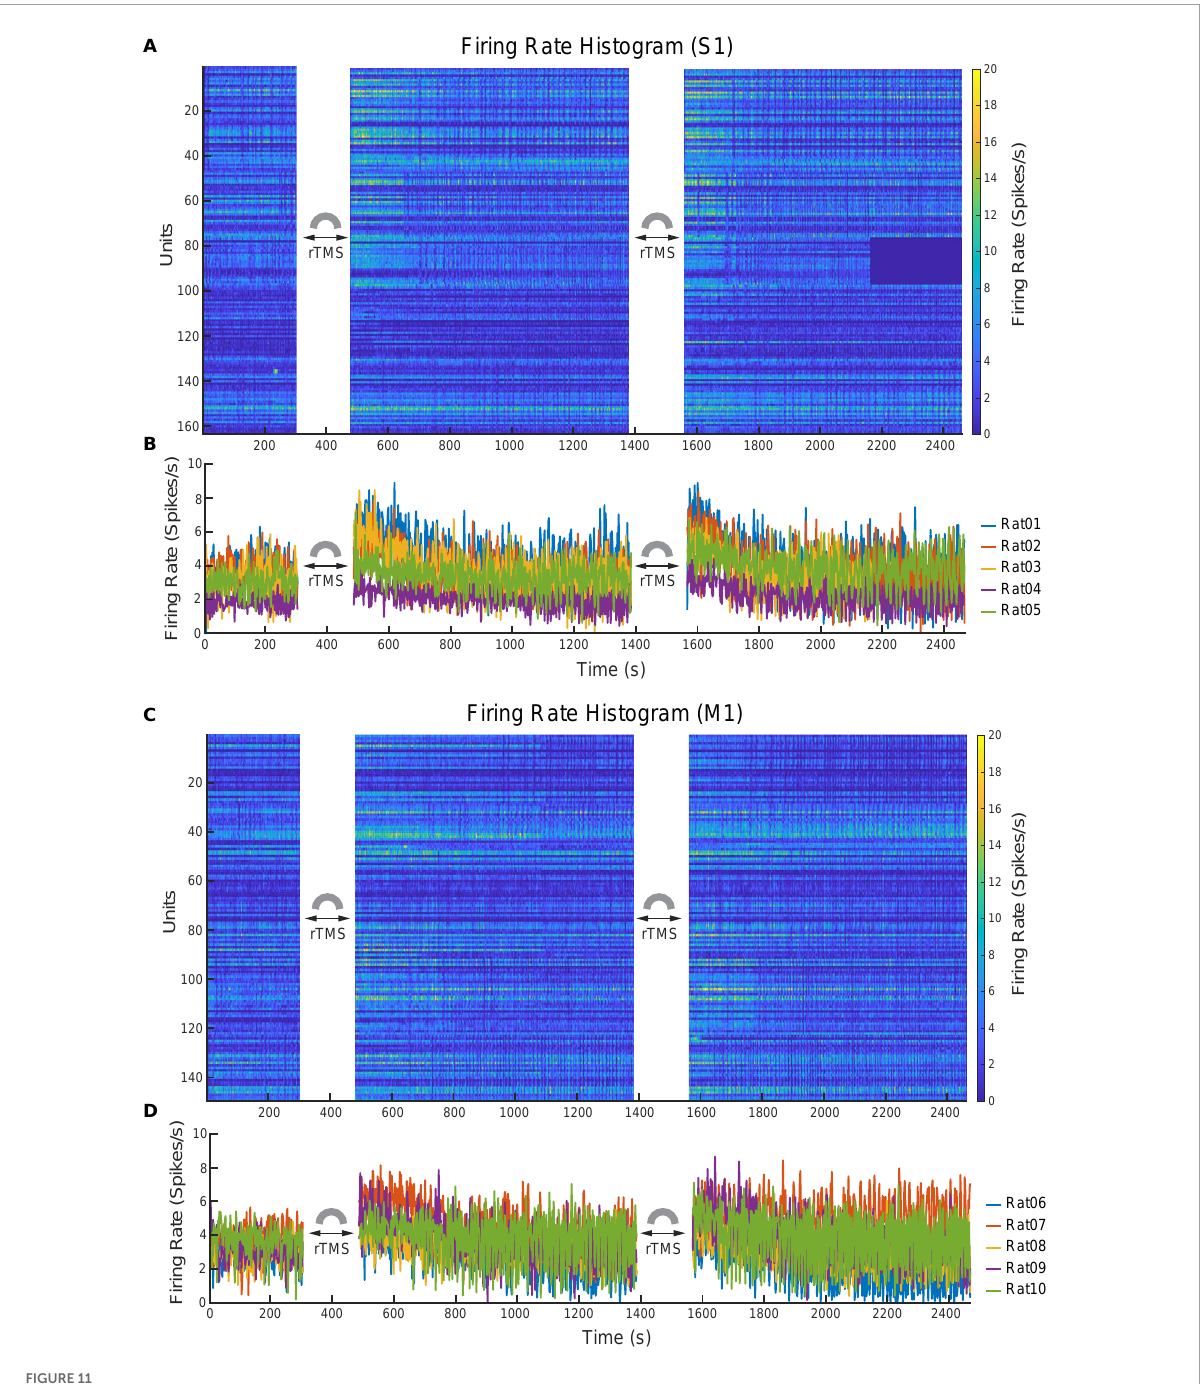
FIGURE11 Changes of neuronal spike firing rates (bin size: 2 s) before and after each course of rTMS. (A) Firing rate histograms of all S1 neurons ( n = 163). (B) Mean firing rates of S1 neurons from each animal ( n = 5). (C) Firing rate histograms of all M1 neurons ( n = 149). (D) Mean firing rates of M1 neurons from each animal ( n =